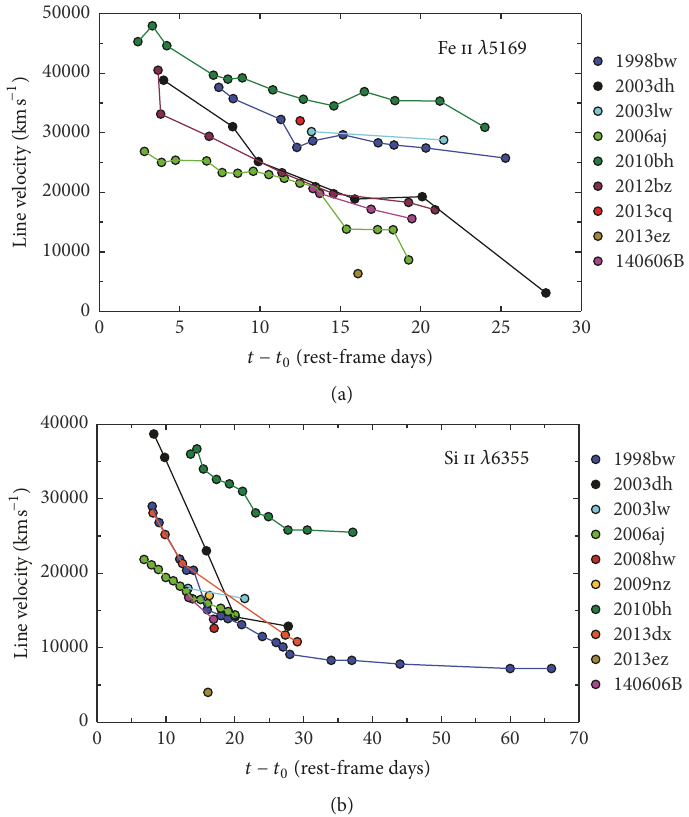
Figure 6: Measured line velocities of a sample of GRB-SNe. See Table 4 for their respective references.